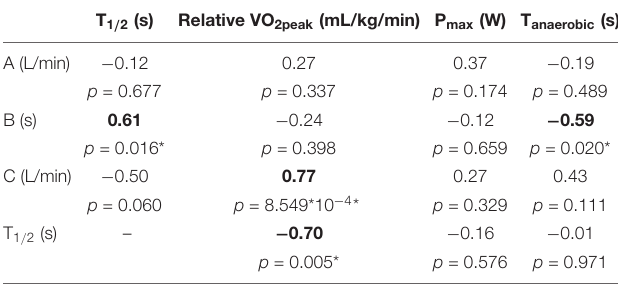
TABLE 1 | Linear Pearson correlation coefficients for the model parameters of oxygen uptake kinetics and traditional markers of cardiorespiratory fitness.